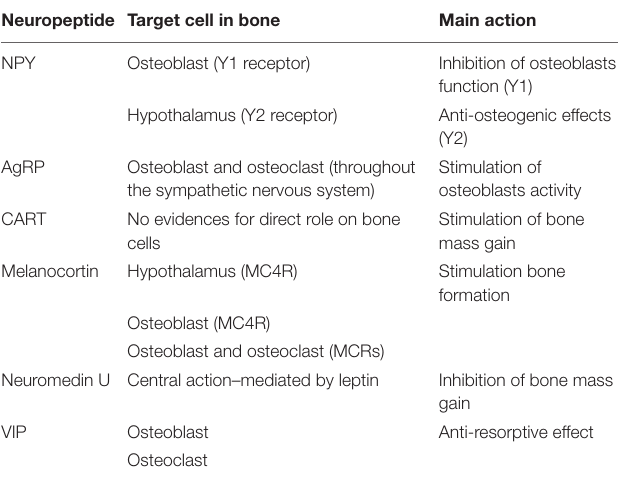
TABLE 3 | Brain to bone communication: